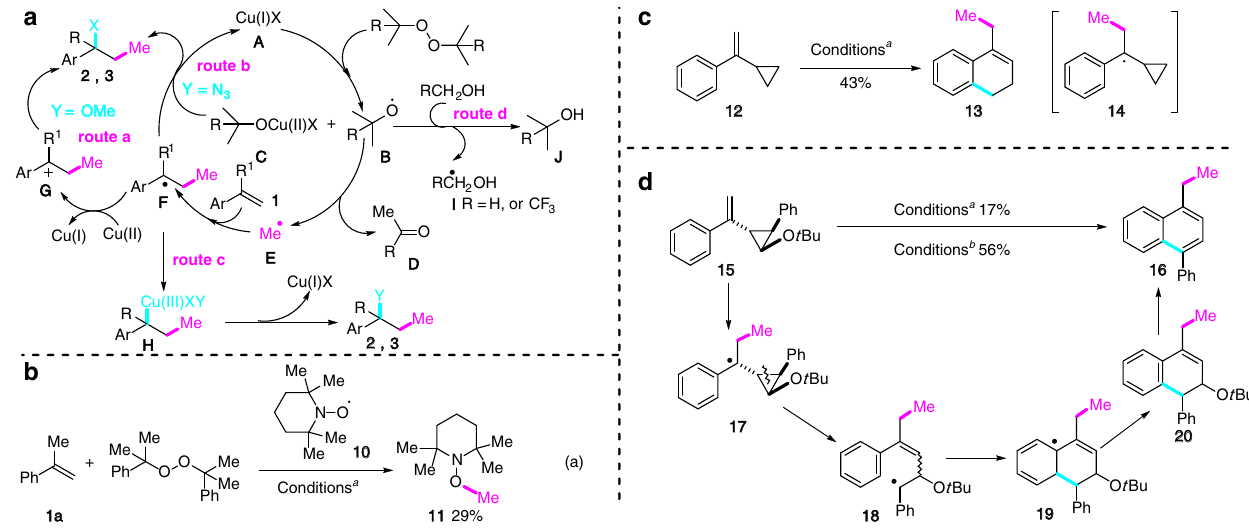
Fig. 5 Mechanistic proposal and control experiments. a Possible reaction pathways. b Radical trapping experiment. c Radical clock experiment. d Super sensitive radical probe experiment. Conditions a : 1a (0.2 mmol), Cu(BF 4 ) 2 (cid:129) 6H 2 O (0.2 equiv), L1 (0.3 equiv), DCP (4.0 equiv), Na 2 HPO 4 (0.2 equiv), MeOH (2.0 mL, c 0.1 M), 120 °C, 4 h; Conditions b : 1a (0.2 mmol), DTBP (0.8 mmol), LiN 3 (0.5 mmol), CuSO 4 (0.002mmol, 0.1 equiv), L2 (0.06